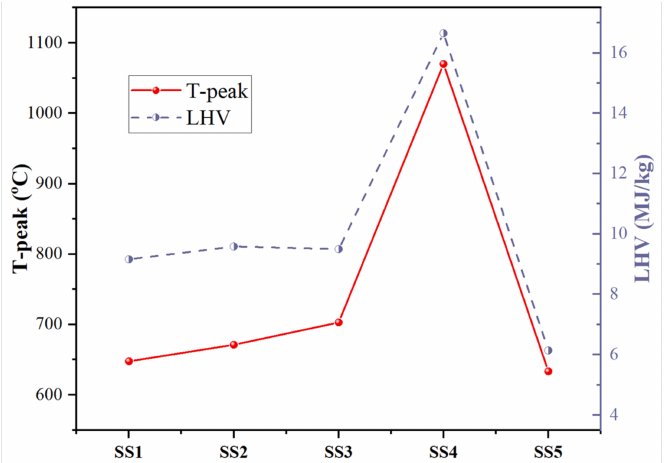
Figure 9. Average peak temperature in self-sustaining smoldering stage and lower heating value of various SS.